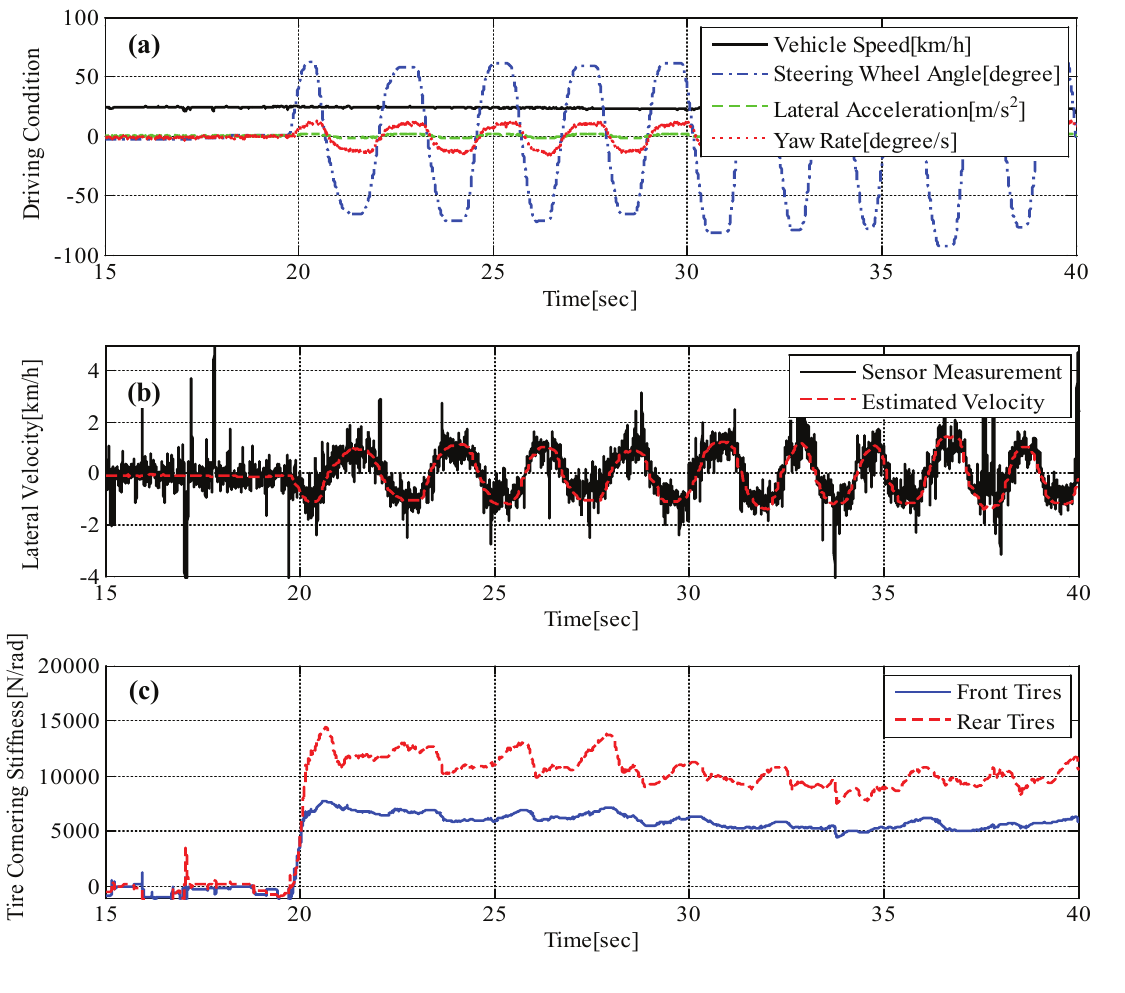
Figure 12. Test result on a low- µ road: ( a ) maneuvering conditions, e.g., vehicle speed, steering angle, measured lateral acceleration and measured yaw rate; ( b ) measured lateral vehicle velocity and estimated lateral vehicle velocity; ( c ) estimated tire cornering stiffness. Table 2. Calculated values for tire cornering